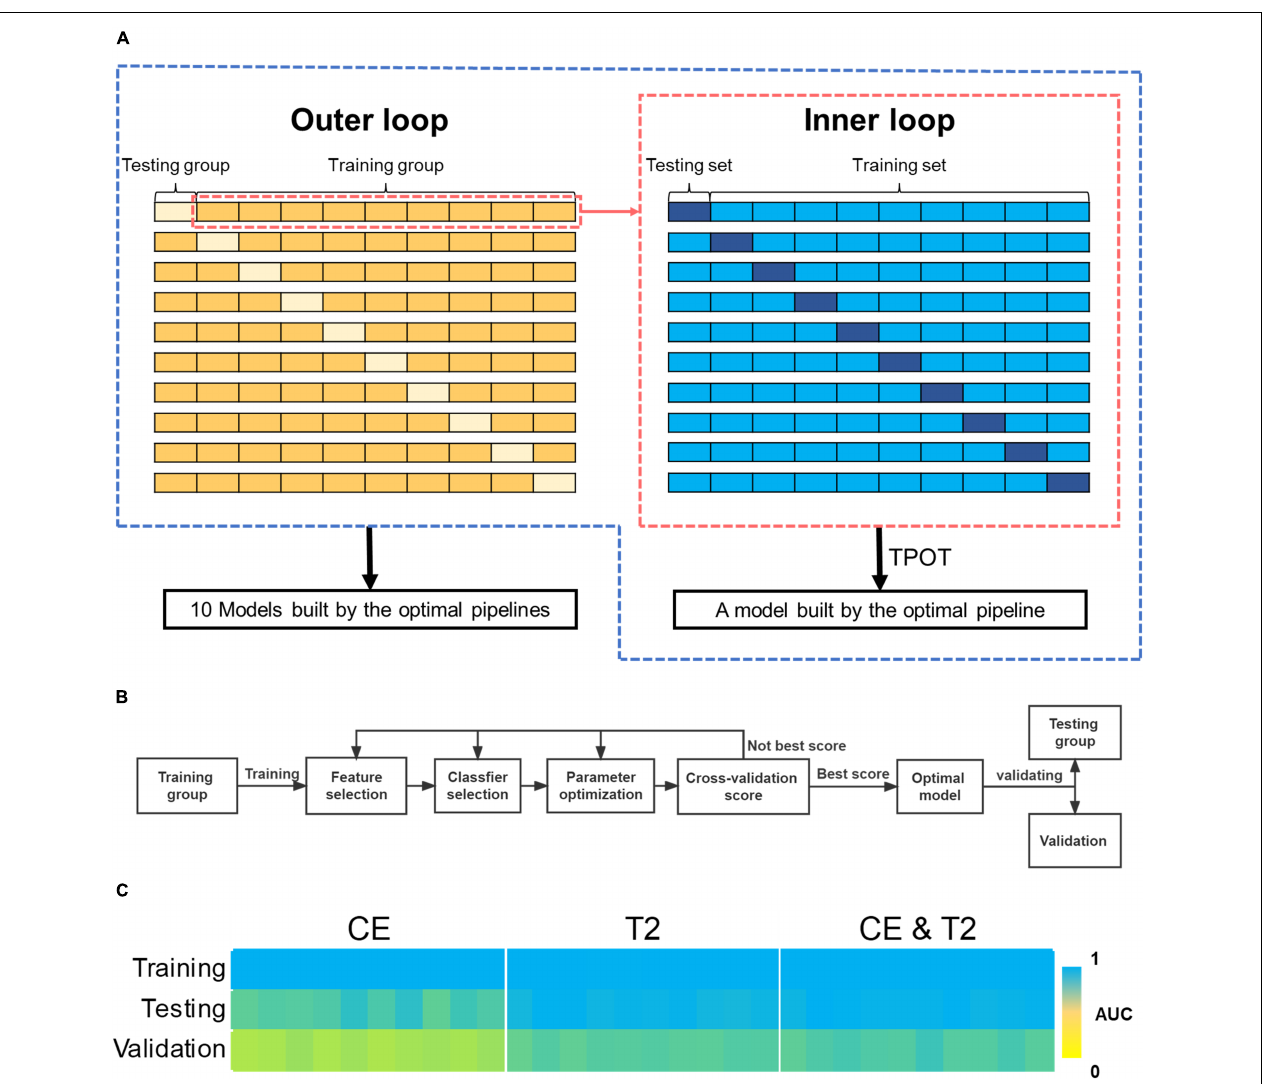
FIGURE 2 | The process of automating machine learning and the predictive performance of the models it builds. (A) The two-layer loops for 10-fold nested cross-validation. (B) The process of automating machine learning modeling and validation using TPOT. (C) AUCs for the models built by the 10-fold nested cross-validation during training, testing, and validation. AUC, areas under the receiver operating characteristic curve; TPOT, tree-based pipeline optimization tool.